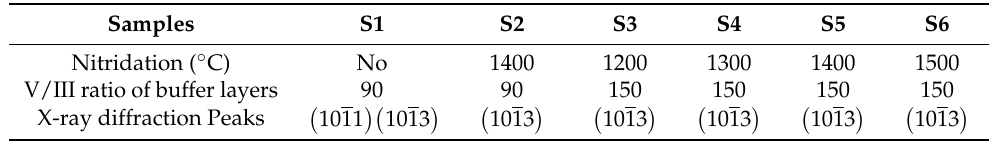
Table 1. Summary of nitridation temperature, V/III ratio of buffer layers and X-ray diffraction peaks for AlN film grown on m-plane sapphire